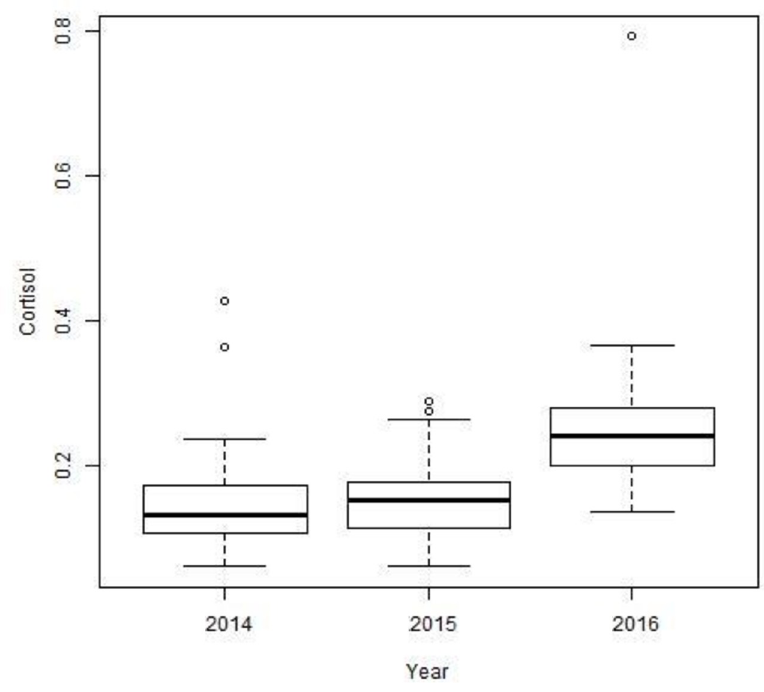
Fig 1. Cortisol levels (pg/mg) for female and male fishers combined in 2014, 2015, and 2016, Sierra National Forest, California, USA. mg (range: 0.0899–0.7922 pg/mg) in the Kings River study site, and 0.146 ± 0.056 pg/mg (range: 0.0609–0.2877 pg/mg) in the Sugar Pine study site.